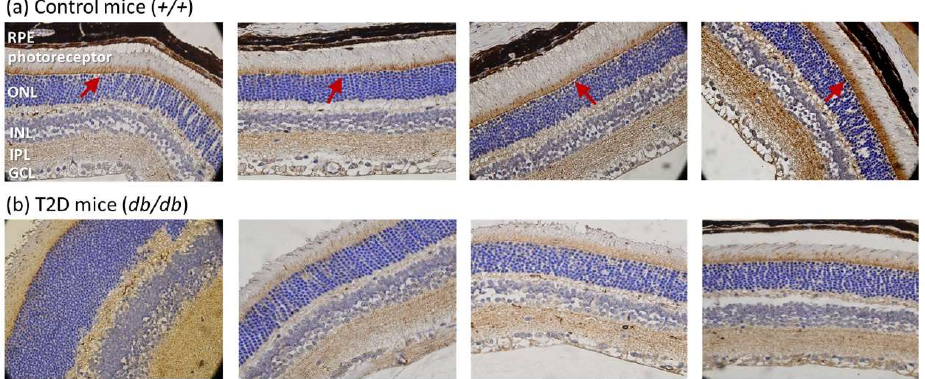
Figure 4. Representative images of immunohistochemical staining of RGC-32 expression in mouse retina at 32 weeks of age (magnification = 400×) ( a ) RGC-32 is prominently expressed in the photoreceptor inner segments in control mice (arrow); ( b ) RGC-32 expression is decreased in T2D mouse retina.